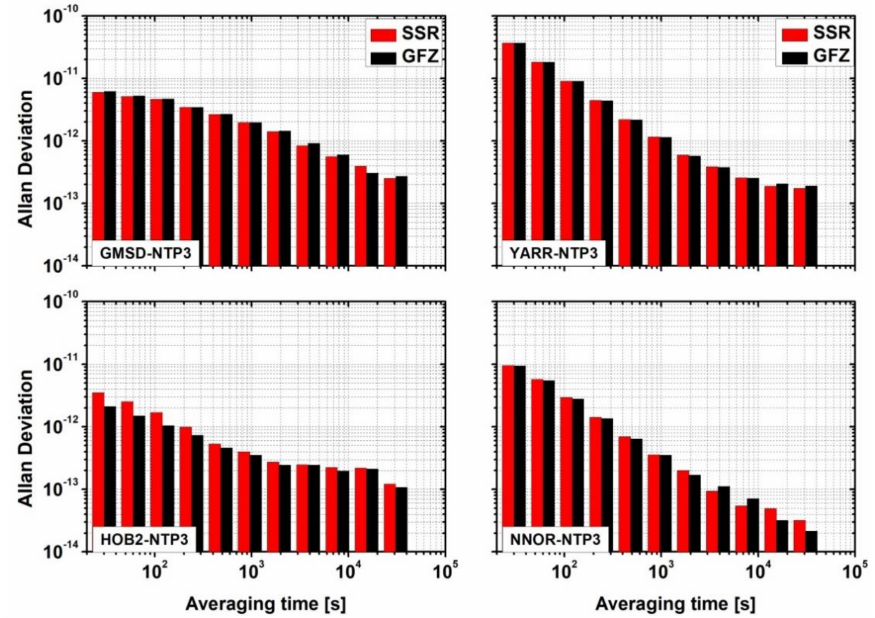
Figure 8. BDS Allan deviation (ADEV) for SSR and GFZ